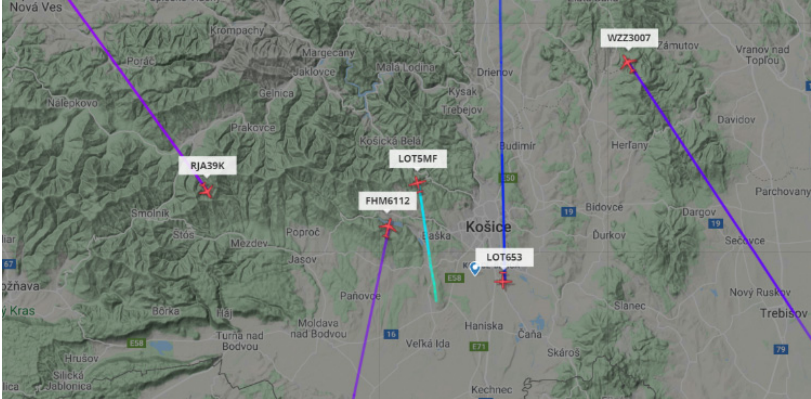
Figure 1. Position of aircraft in the airspace according to flightradar24.